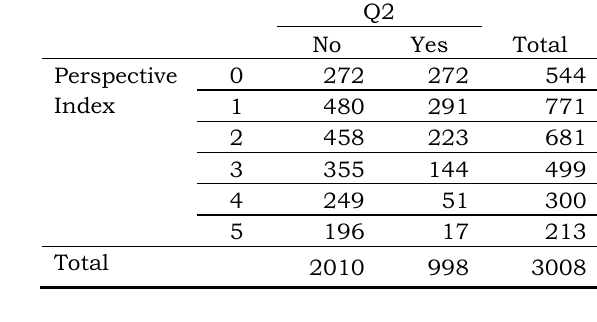
Table 4. Cross-table of the perspective index and